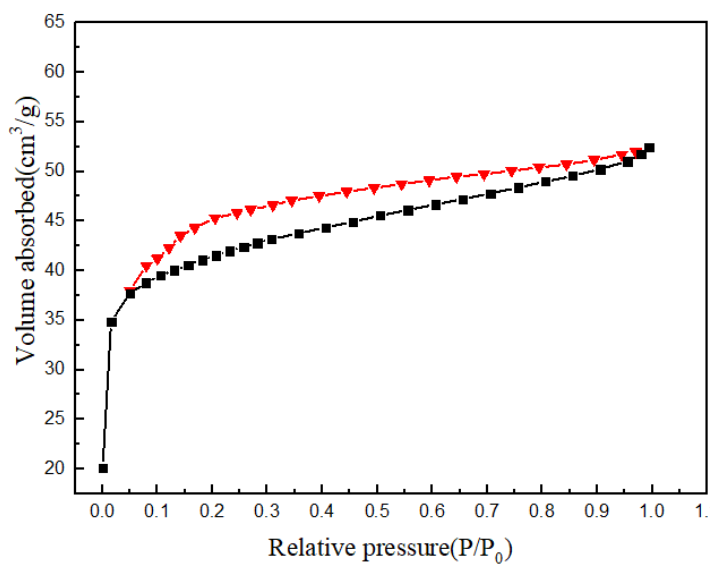
Figure 5. N 2 desorption diagram of ZIF-8(Eu)@Mc-TiO 2 .